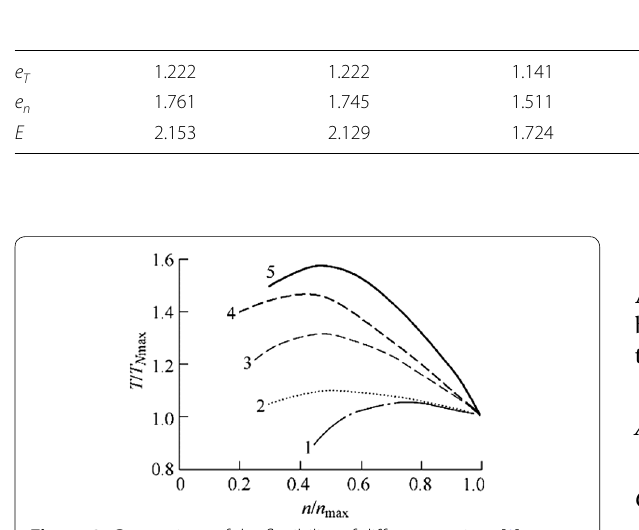
Figure 3 Comparison of the flexibility of different engines [9]: 1. performance vehicle; 2. sports vehicles; 3. passenger vehicles; 4. heavy‑duty trucks; 5. off road vehicles